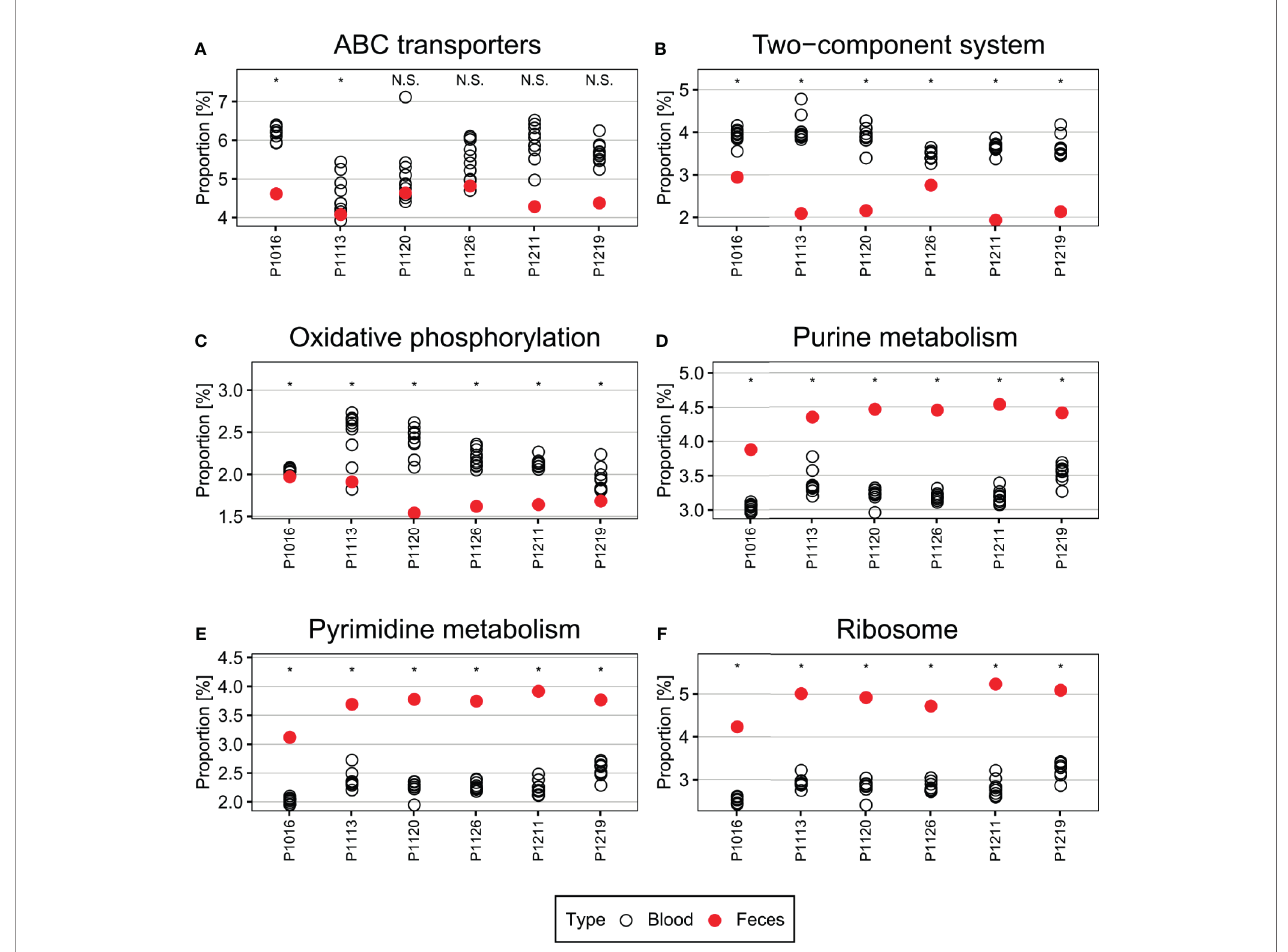
FIGURE 4 | (A – F) Pathways differentially enriched in the blood microbiome. Pathways related to ABC transporters, two-component systems, and oxidative phosphorylation were over-represented in the blood microbiome compared with those in the fecal microbiome. By contrast, pathways related to central metabolism, such as purine and pyrimidine metabolism, and ribosome-related pathways, were under-represented. Wilcoxon test was used to check the signi fi cance of the enrichment and depletion of each pathway. *denotes the p-value of the Wilcoxon test is less than